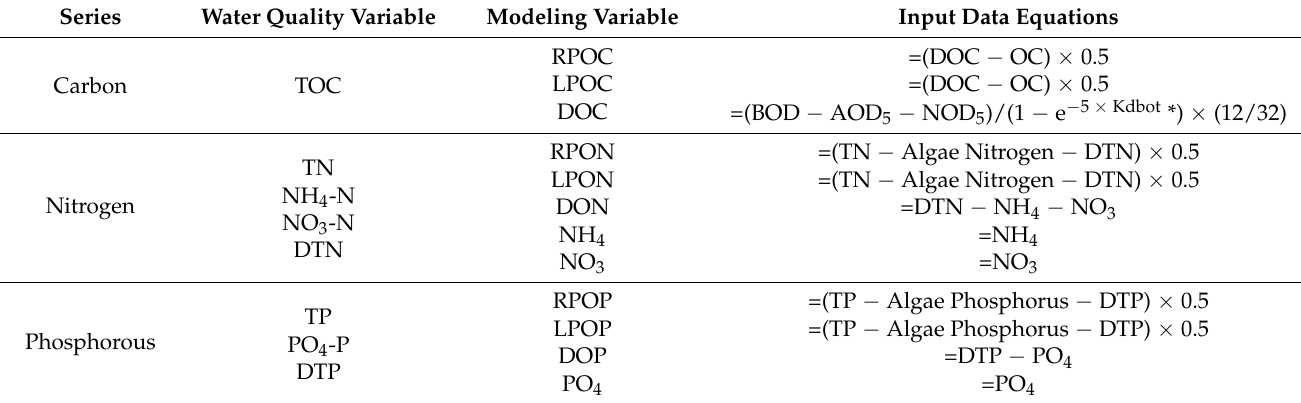
Table 1. Conversion equations for water quality observation data to be used as input data in the EFDC-NIER model. Series Water Quality